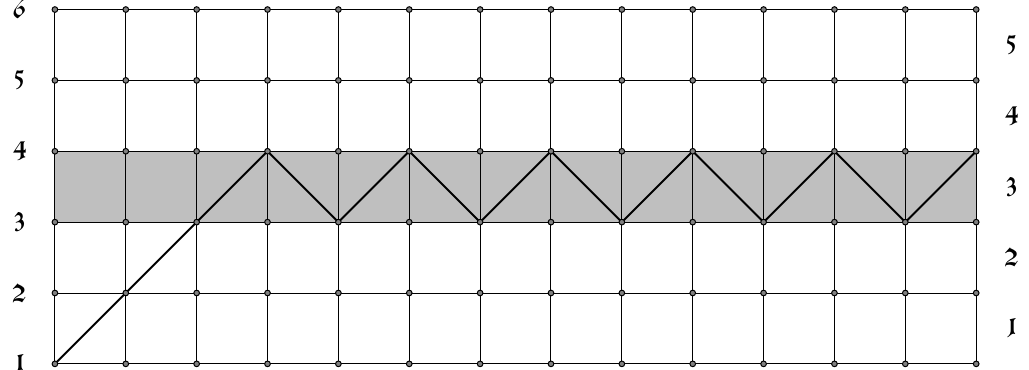
Figure 7 . A non-minimal path in the Lee-Yang restricted solid-on-solid model L 2 ; 5 , labeled by a = 1, b = 2, and c = 3, that contains a valley at ( x; y ) = (1 ; 1) and another valley at (2 ; 2) of weight wt = 1 + 1 + 2 + 2 = 6.